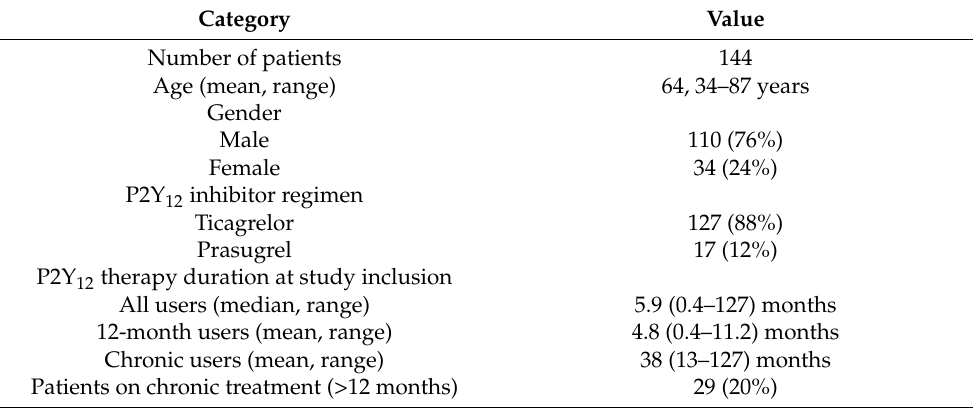
Table 1. Characteristics of patients enrolled in the study.